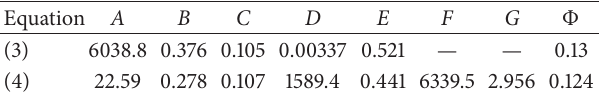
Table 6: Coefficients in (3) and (4) obtained from the classical inverse analysis for the steel DP600.